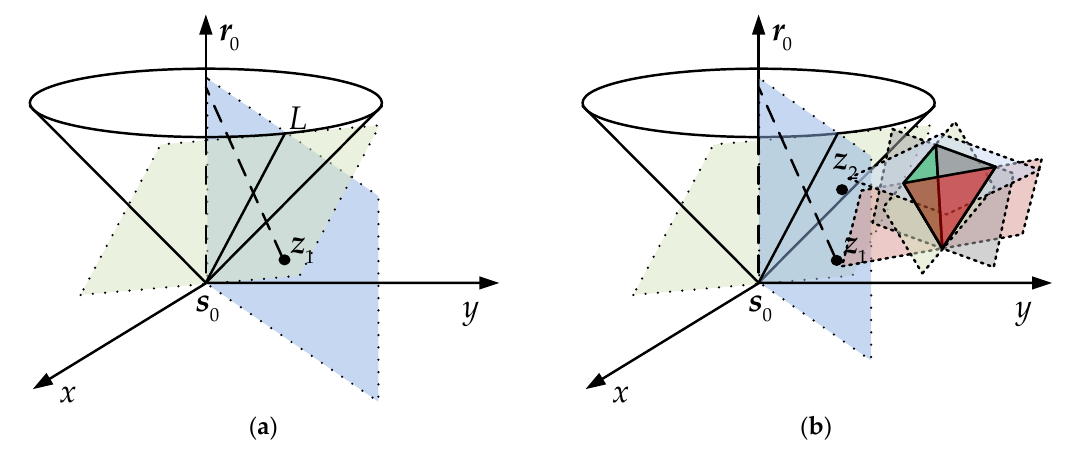
Figure 5. Cone tangent plane constraint localization. ( a ) The cone tangent plane and vertical plane, ( b ) the correction with WLS.